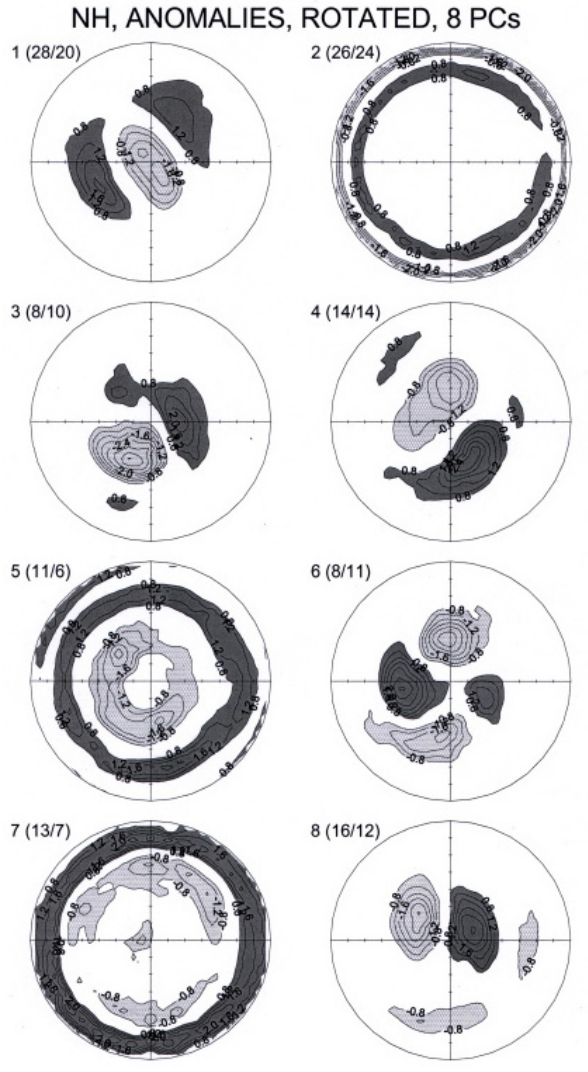
Fig. 7. Scores of rotated PCs for NH. Each PC is indicated by its number; the numbers of corresponding positive and negative types are given in parentheses. Contour interval is 0.4; zero and ± 0.4 isolines are omitted; positive (negative) anomalies exceeding 0.8 (below − 0.8) are in dark (light)